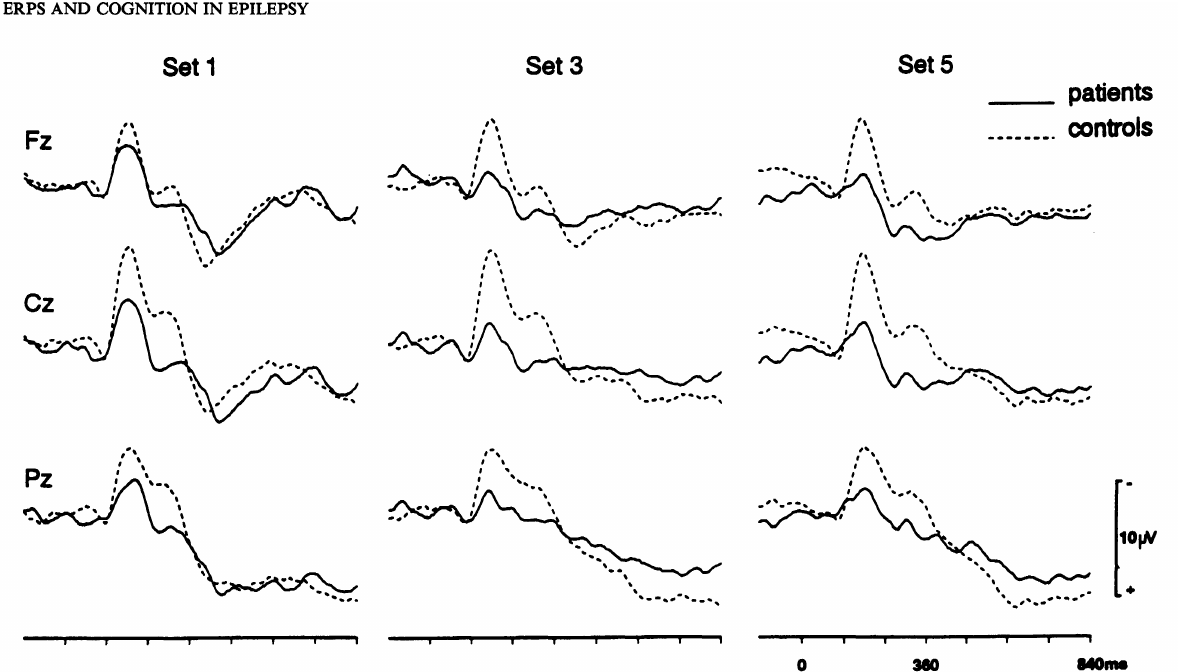
FIG. 3. Superimpositions of group averages of positive probes of patients (n = 17) and controls (n = 17) by set size. Ampli tude differences in the early section of the waveform (N170. P250 and N290) can be seen across all set sizes. Note that where as N290 and P250 are shifted with respect to baseline, they are relatively well preserved peak-to-peak. By contrast, the P400 is relatively unchanged with respect to baseline. but its amplitude is reduced when measured from the preceding N290 peak.